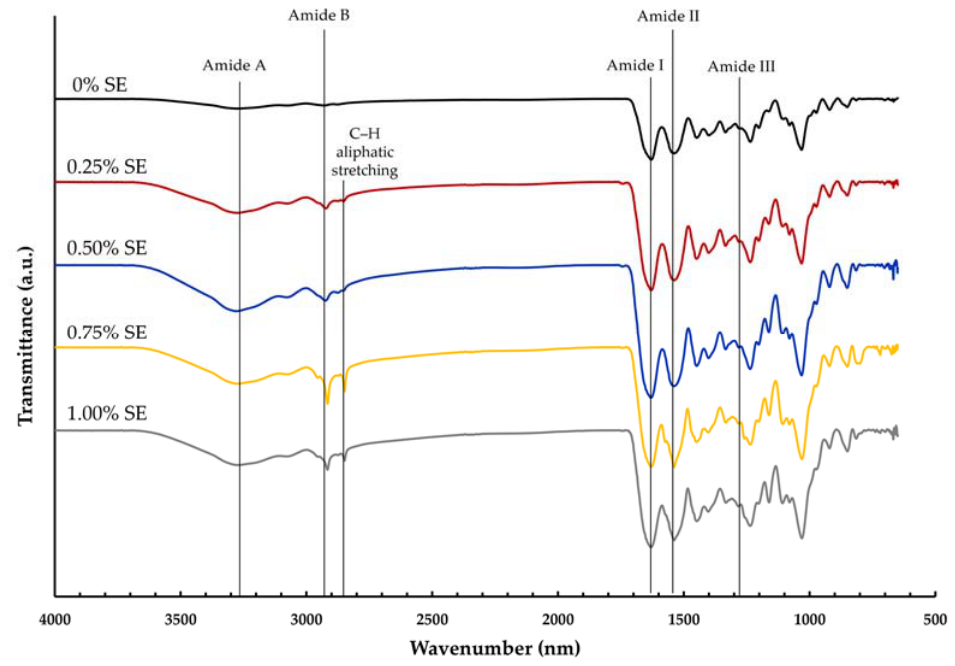
Figure 2 . FITR spectra of gelatin films incorporated with sappan heartwood extract at different concentrations . Numbers denote the concentrations of SE (% , w / v ). concentrations. Numbers denote the concentrations of SE (%, w / v ). Table 4. Antioxidant and antimicrobial properties of gelatin films incorporated with sappan heart- wood extract (SE) at different